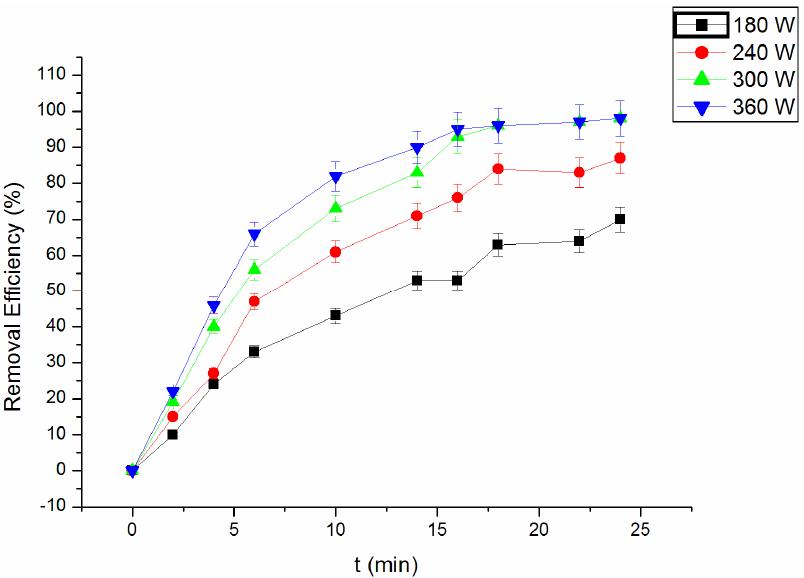
Figure 3. Effect of ultrasonic power on the RhB removal efficiency.